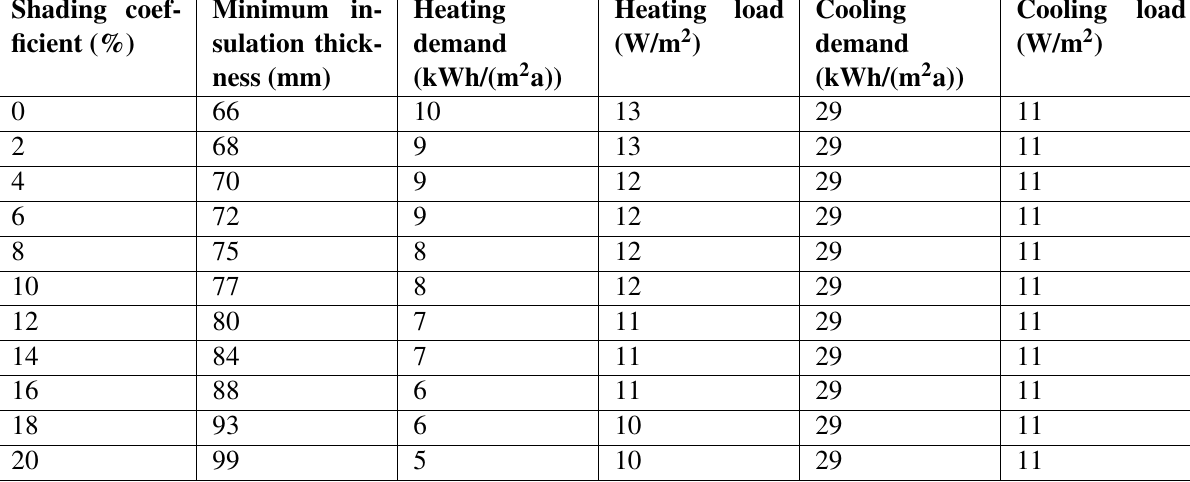
Table 2 Relationship between shading coefficient and minimum insulation